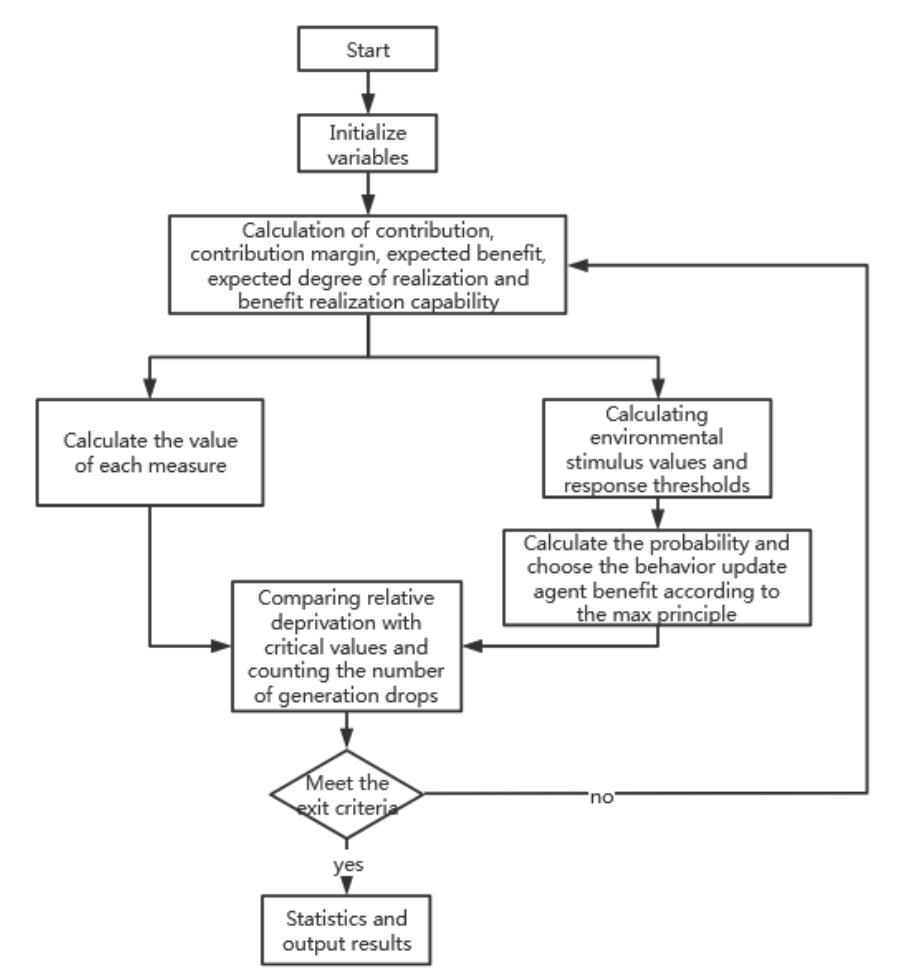
Figure 2. Flow chart of the extended benefit allocation algorithm.